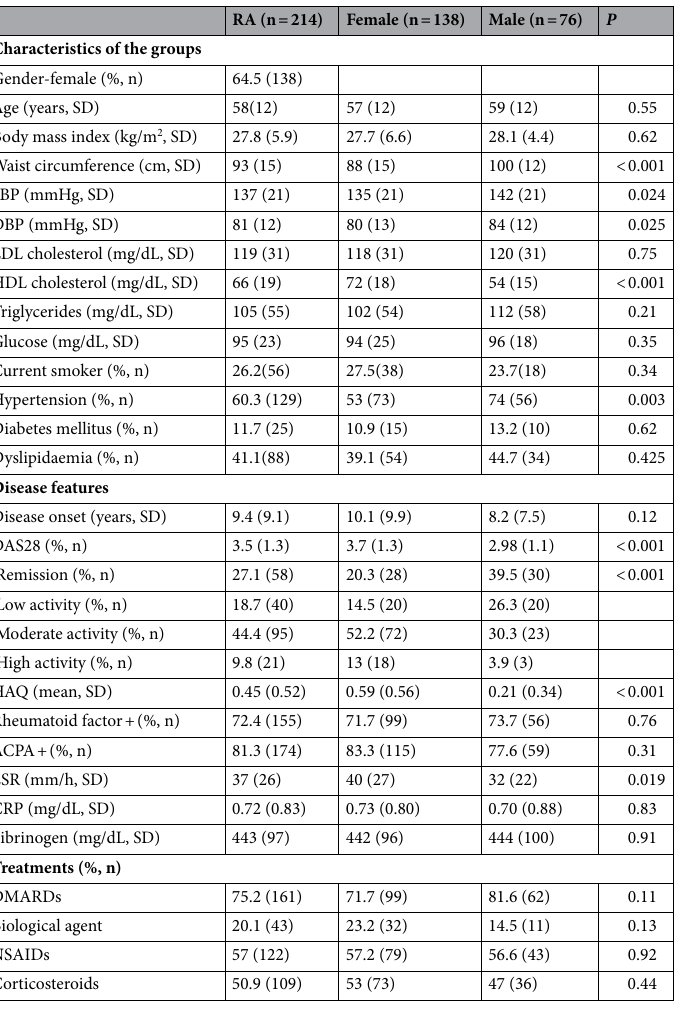
Table 1. Description of general characteristics, Disease features, and treatments of RA patients overall and stratified by gender. n = number of individuals, SBP = systolic blood pressure, DBP = diastolic blood pressure, HAQ = health assessment questionnaire index, ACPA = citrullinated anti-cyclic peptide antibodies, ESR = erythrocyte sedimentation rate, CRP = C-reactive protein, DAS28 = disease activity score, DMARDs = disease-modifying antirheumatic drugs, NSAIDs = non-steroidal anti-inflammatory drugs, SD = standard deviation, p = p